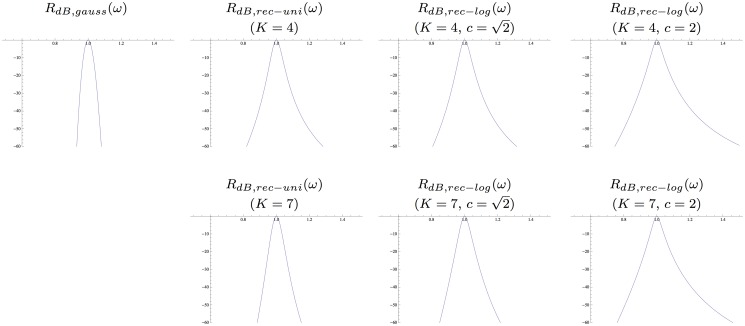

Graphs of the frequency selectivities of Gaussian and time-causal window functions with the temporal extent proportional to the corresponding wavelength of the spectrogram with n = 8.For the time-causal filters, K = 4 or K = 7 filters have been coupled in cascade. For the logarithmic distribution, the ratio between successive temporal scale levels τ
k = c
2(k − K)
τ has been determined from c=2 or c = 2. (Horizontal axis: Angular frequency ω in units of ω
0. Vertical axis: dB values down to -60 dB.)